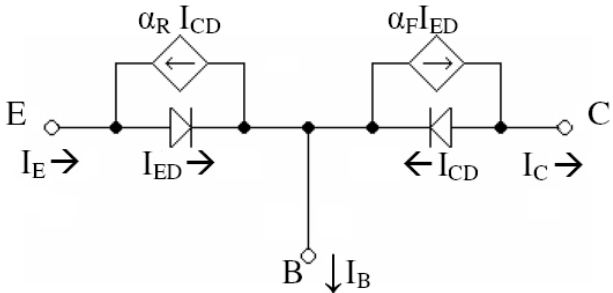
Figure 4. Ebers–Moll model for the PNP